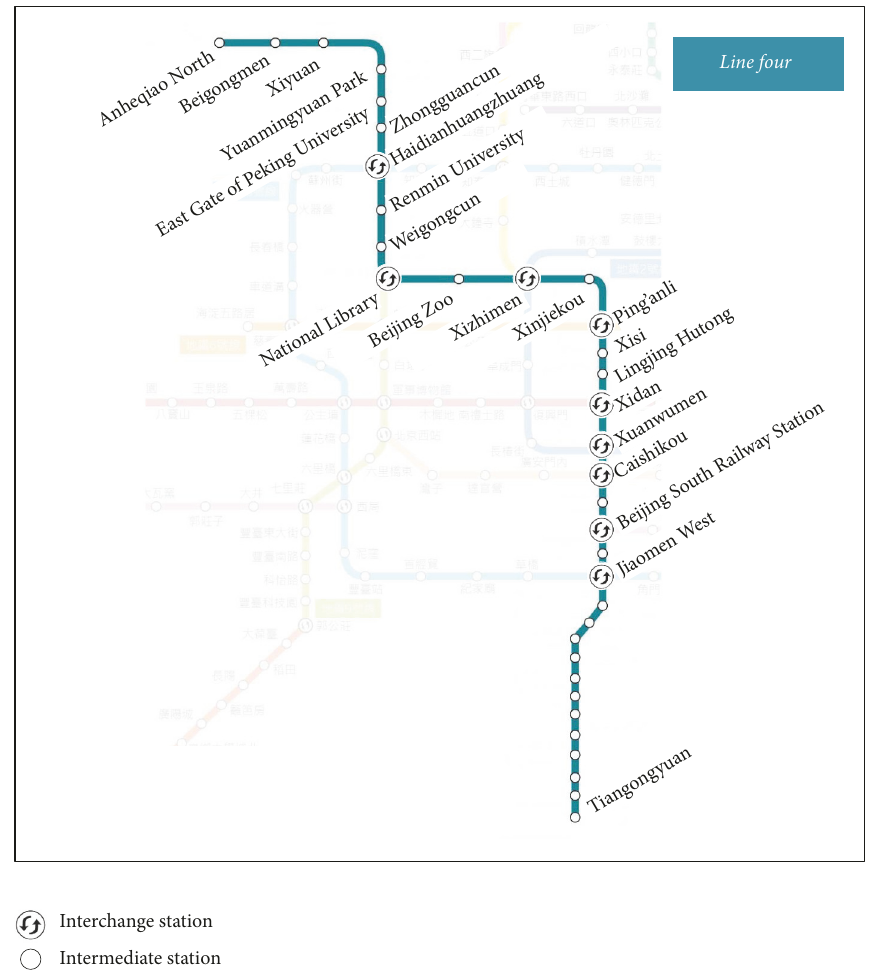
Figure 1: Stations of line four of the Beijing urban rail transit